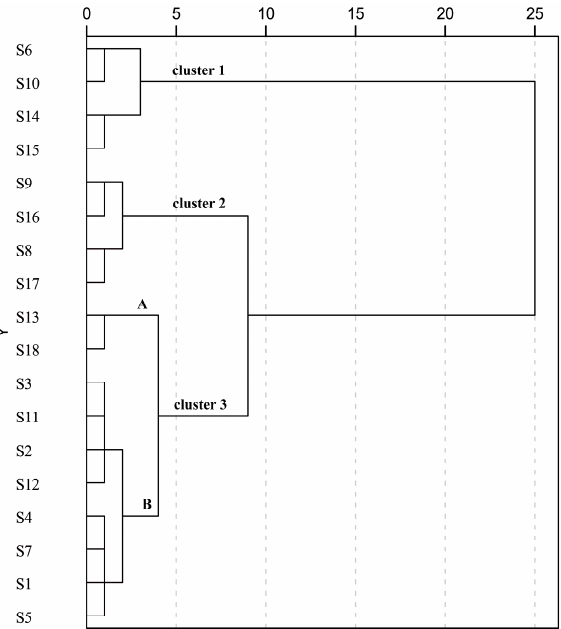
Figure 4. Dendrogram of hierarchical cluster analysis for leaf samples S1–S18 of C. paliurus (detailed geographical information for S1–S18 is listed in Table 1 ). A and B represent two subgroups under cluster 3 based on the squared Euclidean distance.